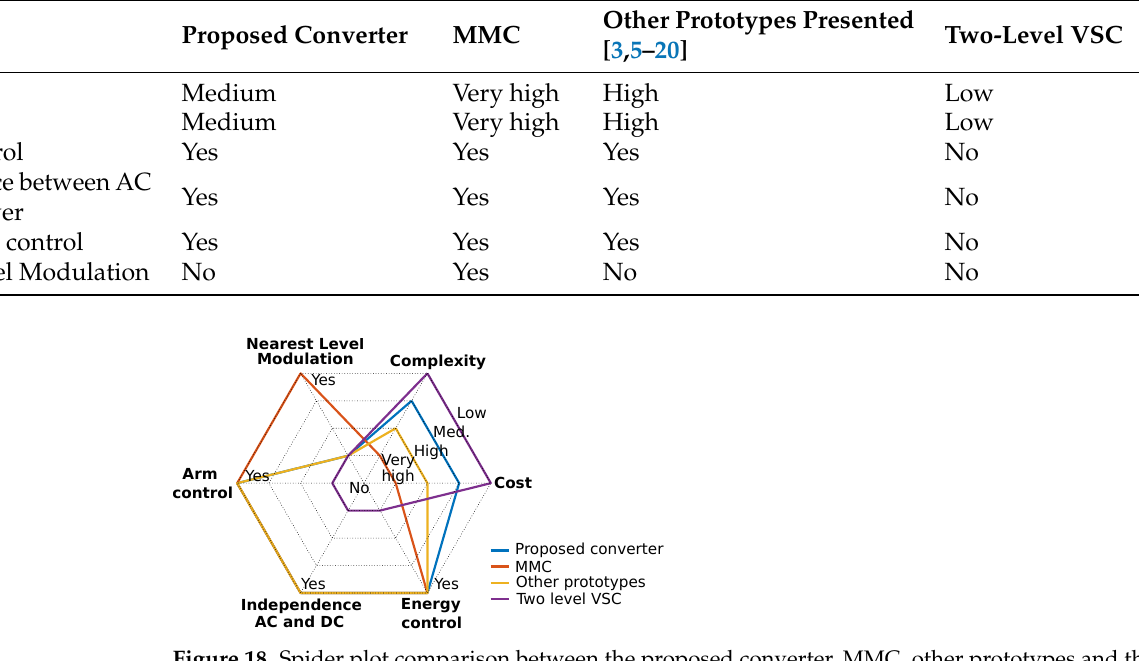
Figure 18. Spider plot comparison between the proposed converter, MMC, other prototypes and the two-level